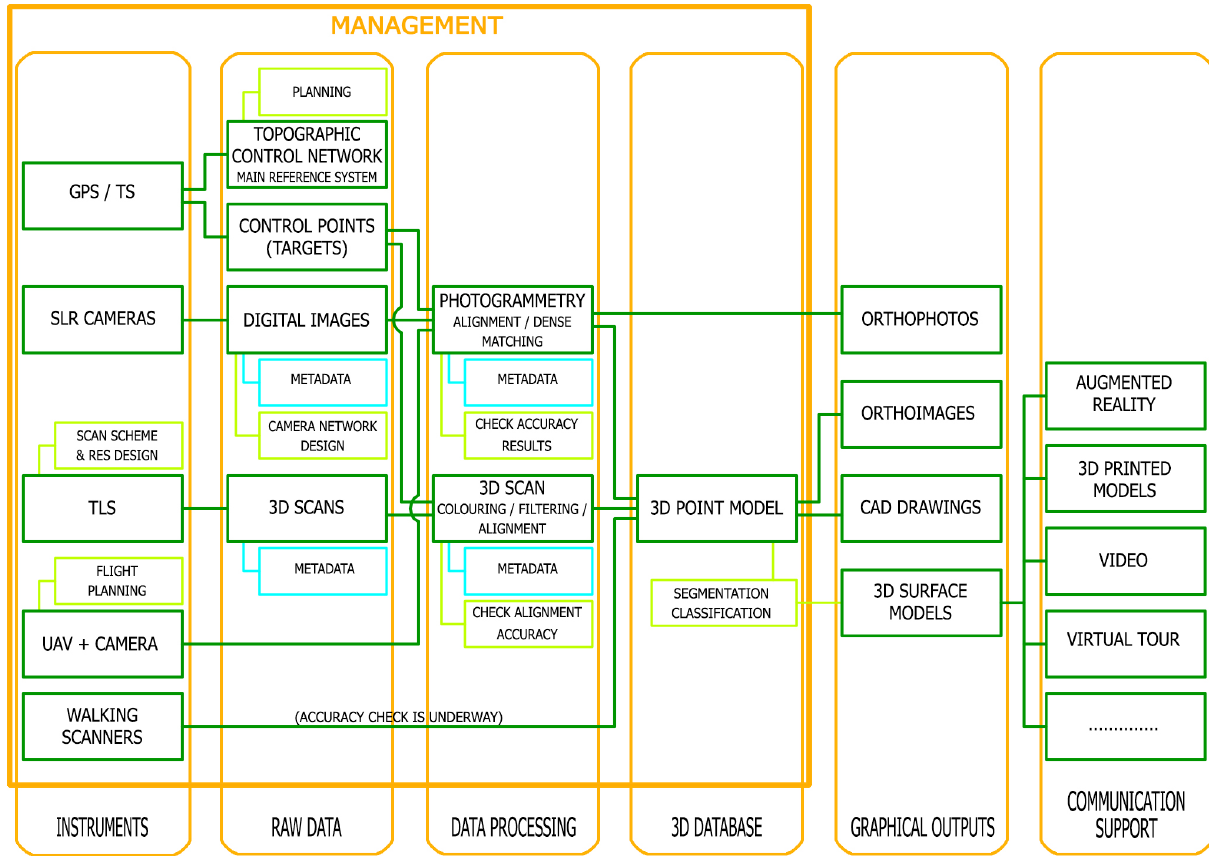
Figure 2. The digitization workflow adopted in the